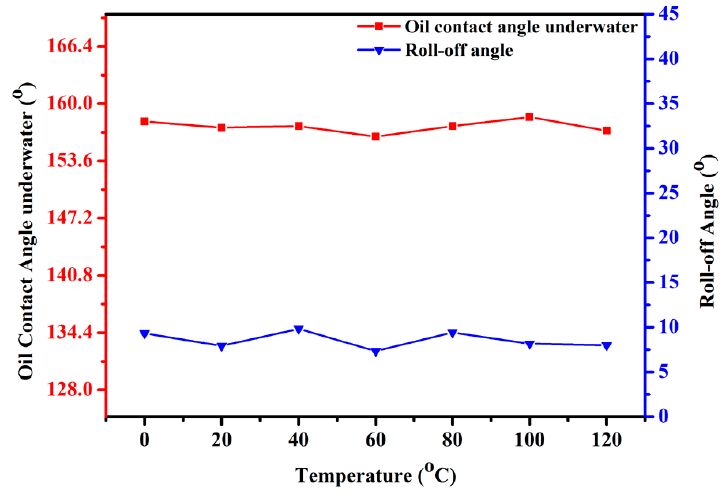
Figure 10. Variation in the underwater oil CA and roll-off angles of the CSPNM with temperature increase.